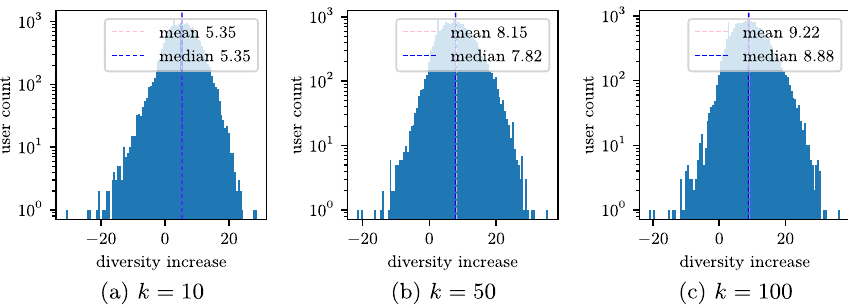
Fig. 5 Distribution of the diversity increase ( α = 2 ) for different numbers of